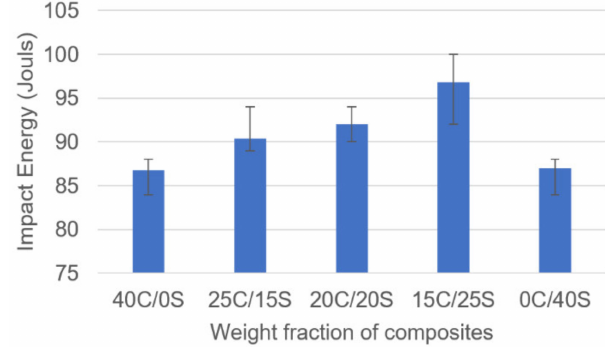
Figure 9. Impact strength vs. fiber weight fractions.